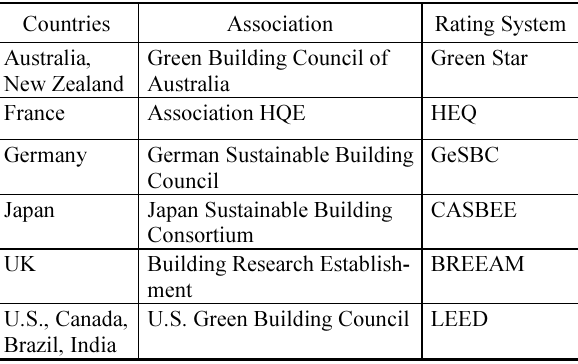
Table 1. Sustainable rating systems around the world